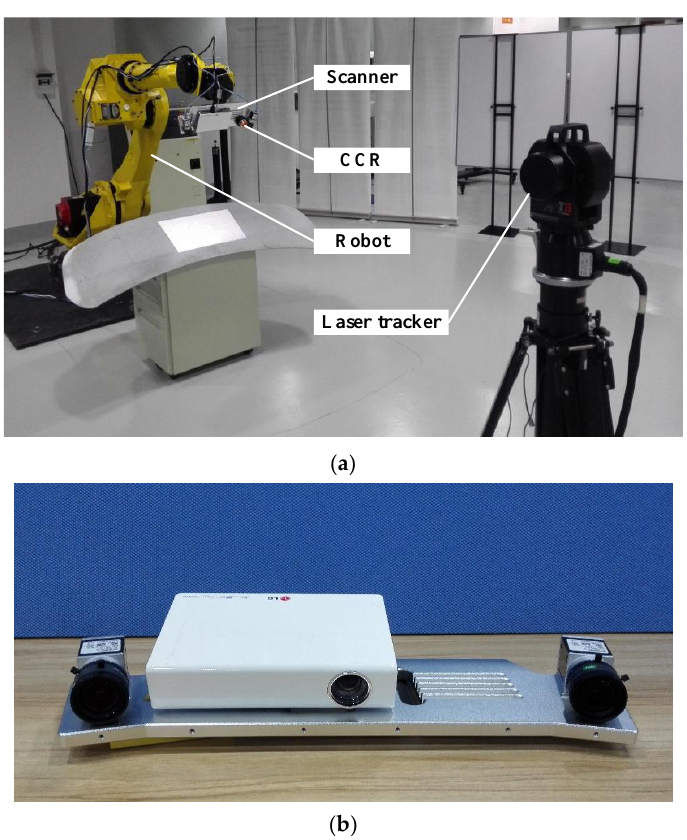
Figure 3. ( a ) Construction of the integrated 3D scanning system; ( b ) Binocular structured light scanner.